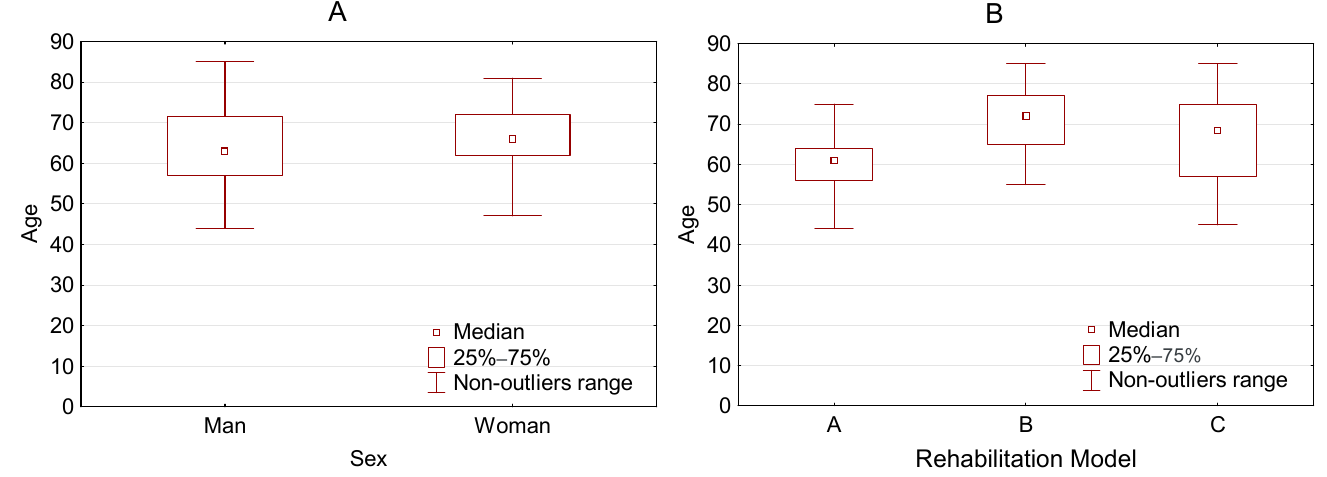
Figure 1. Characteristics of examined group. ( A ) Age vs. Sex and ( B ) Age vs. Rehabilitation Model. Patients were admitted to the cardiac rehabilitation ward twice: (1) in the 3rd month (mean 74 days; ±16.5; range 31.0–90.0) after MI, and then (2) in the 6th month (mean 167 days; ±16.1; range 125.0–186.0) after the last session in the rehabilitation center. The inter- val between the first and second admission to the ward for each patient was 3 months. During the 3-month break, the patient performed the recommended physical activity. Outpatient rehabilitation was provided for 20 days (4 weeks, each 5 treatment days and 2 days’ break). During the treatment, patients followed a rehabilitation program. The dura- tion of the cardiac rehabilitation program in Poland results from financing by the National Health Fund (the state payer of medical benefits) and lasts up to a maximum of 24 person days over three months (quarter). In our research, we based on the Experts of the Section of Cardiac Rehabilitation and Physiology of the Effort of the Polish Society of Cardiology “Recommendations for Comprehensive Cardiological Rehabilitation” [14]. Rehabilitation management was based on the guidelines of The European Association for Cardiovascu- lar Prevention and Rehabilitation (EACPR): phase I—in-hospital program; phase II—early post-discharge program. This period is usually 2–16 weeks after discharge; phase III— long-term maintenance program [15]. Patients were initially assessed for physical performance based on the result of the exercise stress test on the treadmill and the risk of cardiovascular complications and then assigned to one of the rehabilitation models: A (61.1%), B (29.4%), or C (9.5%) (Table 1, Figure 1B). Table 1. Exercise models carried out in cardiological rehabilitation. Model